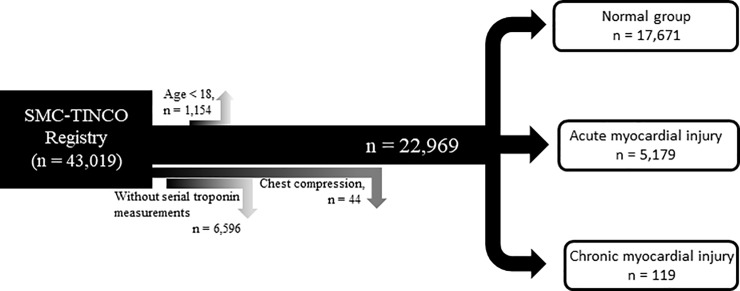
Patient flowchart.